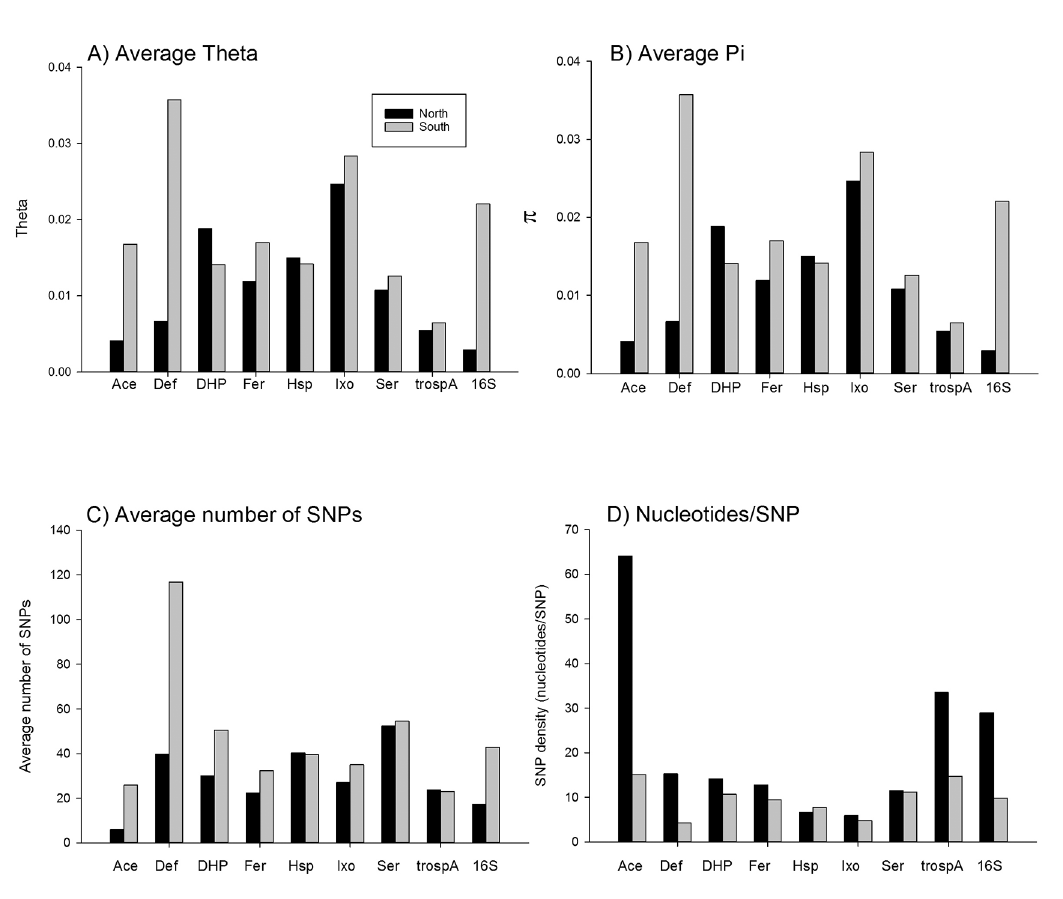
Fig 2. Measurement of genetic diversity among the 8 nuclear markers and at the 16S gene. A), average θ values and B) π values, C) The average numbers of SNPs and D) SNP density/ nucleotides.